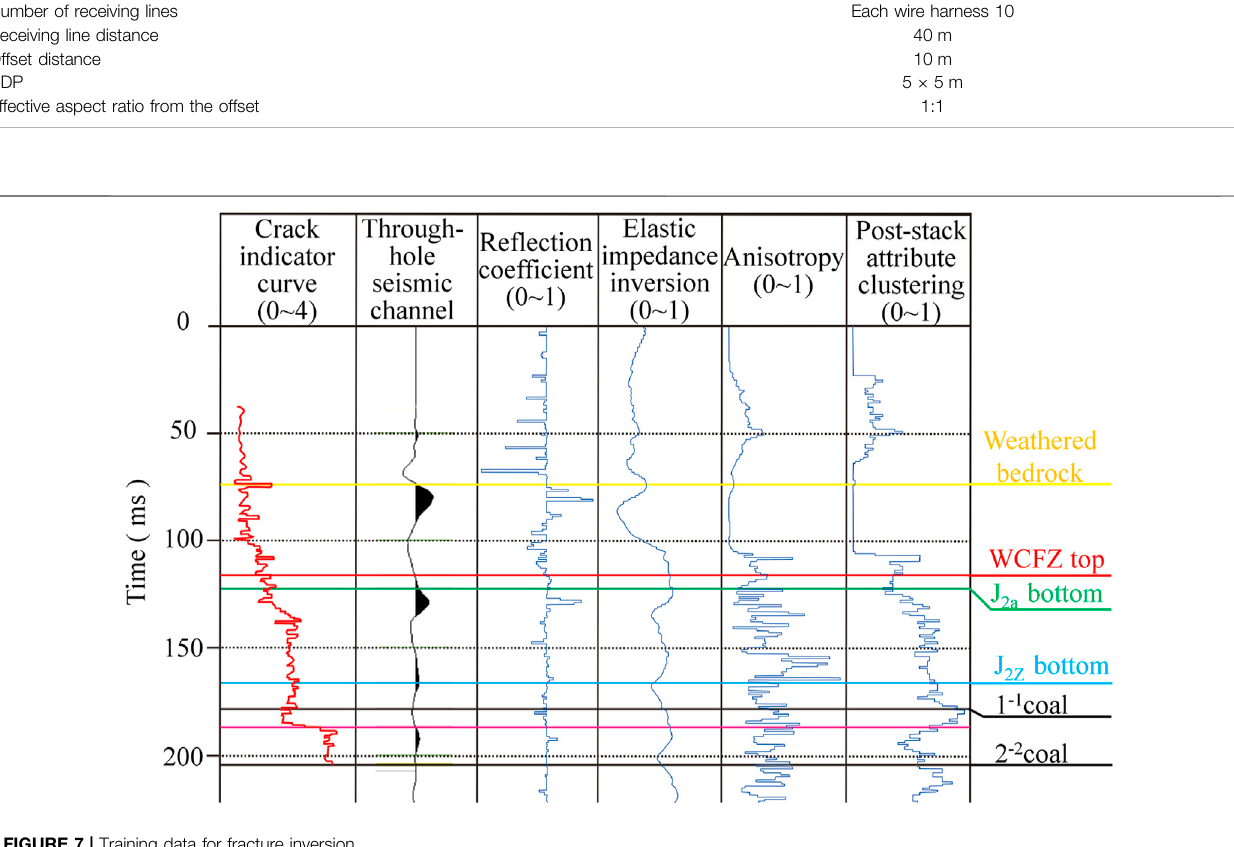
FIGURE 7 | Training data for fracture inversion.